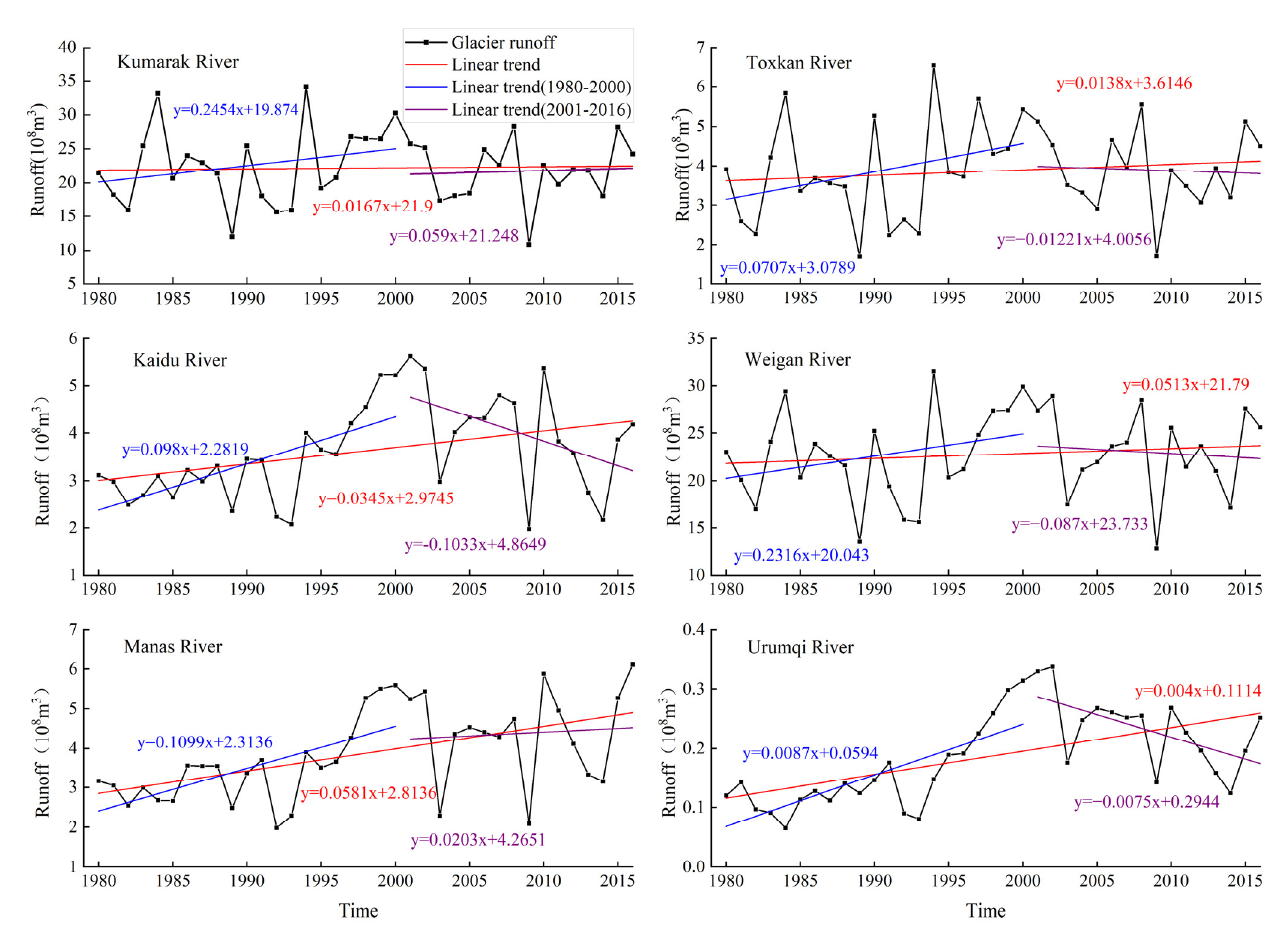
Figure 8. Inter-annual variations in glacier runoff in six watersheds.